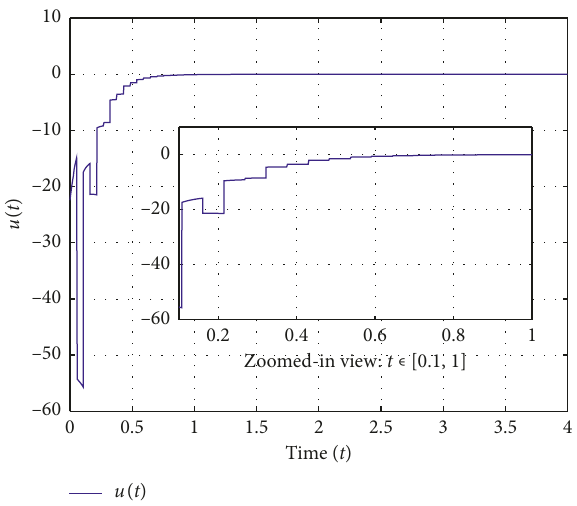
Zoomed-in view: t ∊ [0.1,